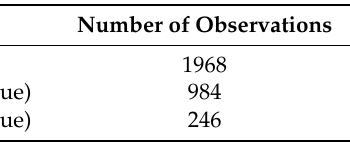
Figure 4. ( a ) Pluviometric network used in the synthetic experiment. ( b ) Time series of precipitation values: RainFARM-precipitation field and interpolated precipitation field. ( c ) Mean (left) and hourly maxima (right) values of the RainFARM precipitation fields. ( d ) Mean (left) and hourly maxima (right) values of the interpolated precipitation field. Note that the shape of the Cervaro River Catchment shown in Figure 4c,d (and in the following one) is slightly different from the shape shown in Figures 1, 2 and 4a. This difference is due to the hydrological conditioning of the SRTM DEM used in the model simulation, which slightly changed the watershed boundaries. Table 1. GEO SAR product specifications considered in the SM-DA exercises, and total number of GEO SAR-like observations that were assimilated in the whole model domain. The total number of the hourly time steps (i.e., TRUTH SM Maps) that composed the TRUTH and all the PERTURBED runs (including the OL) is 2952 (which corresponds to the number of hours in the time period ranging from 1 October 2016 00:00 to 31 January 2017 23:00).